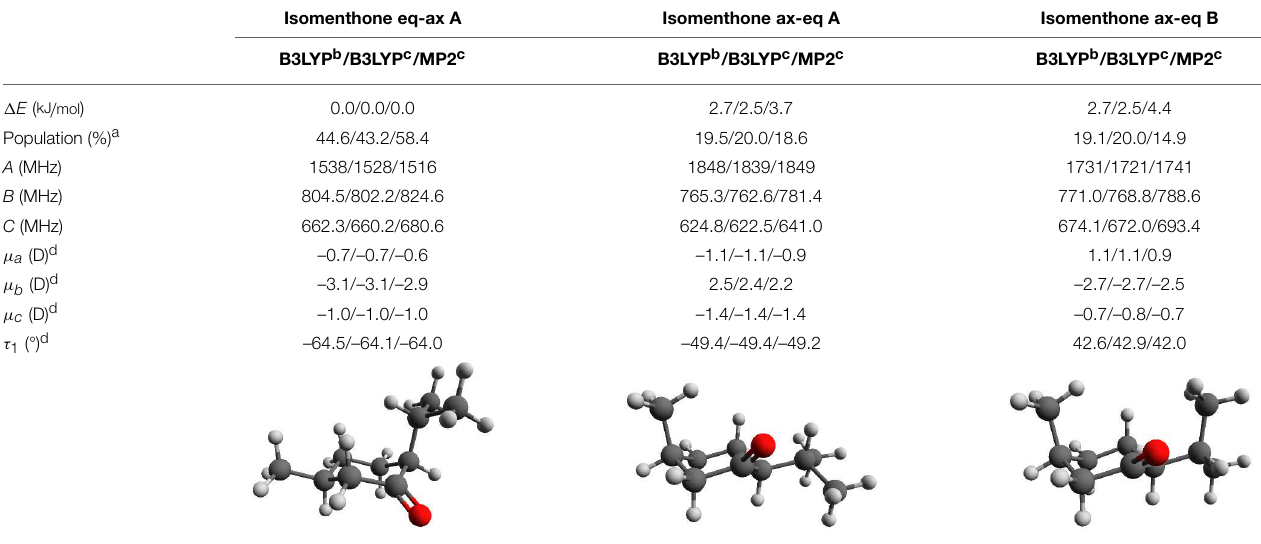
TABLE 5 | Calculated relative zero-point corrected energies, Boltzmann populations, rotational constants, dipole moments, and torsional angles for the three lowest energy conformers of isomenthone. The results were obtained using three different combinations of theoretical methods and basis sets and they are stated in this order: B3LYP/aug-cc-pVTZ / B3LYP/6-311 ++ G(d,p) / MP2/6-311 ++